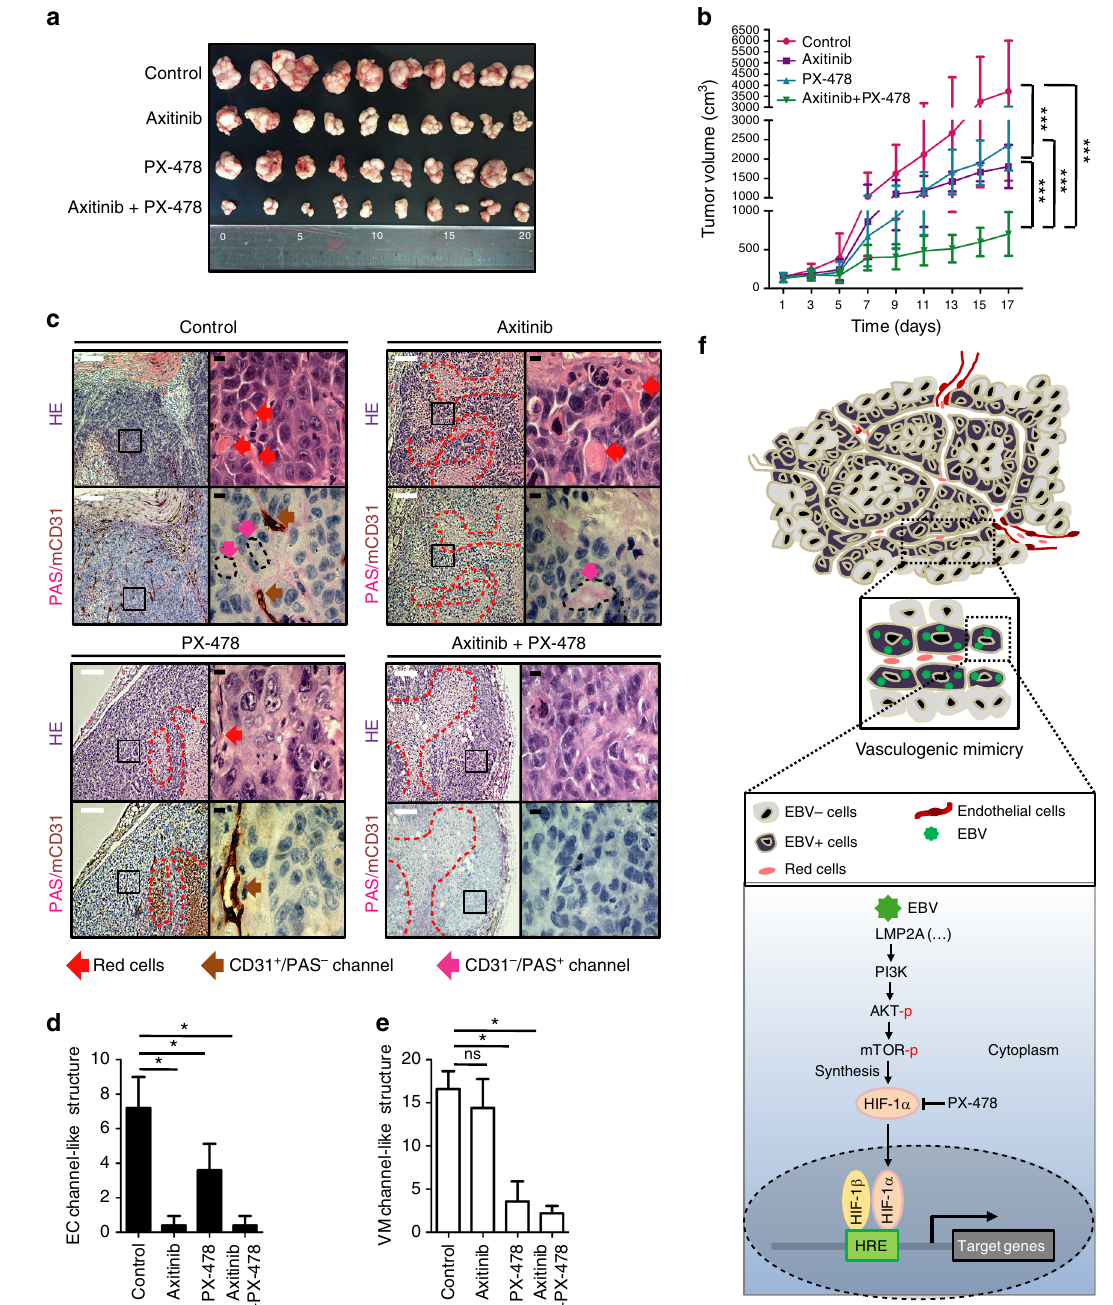
Fig. 8 Synergistic effects of PX-478 and Axitinib in NPC-EBV. a Image of CNE2-EBV xenograft tumors from mice treated with vehicle, Axitinib alone